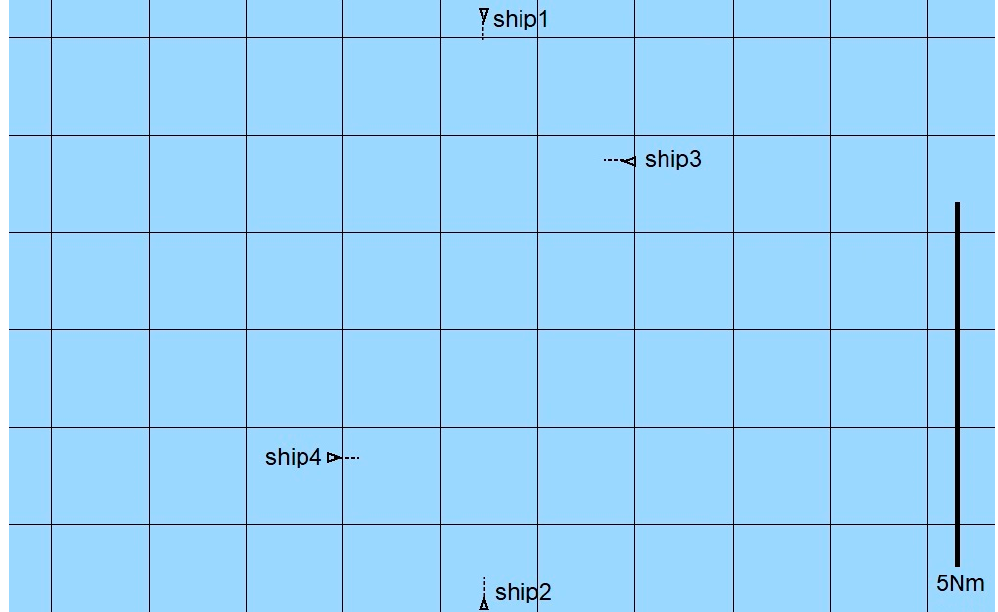
Figure 11. Scenario of a collision situation at encountered by four ships — Example 2.